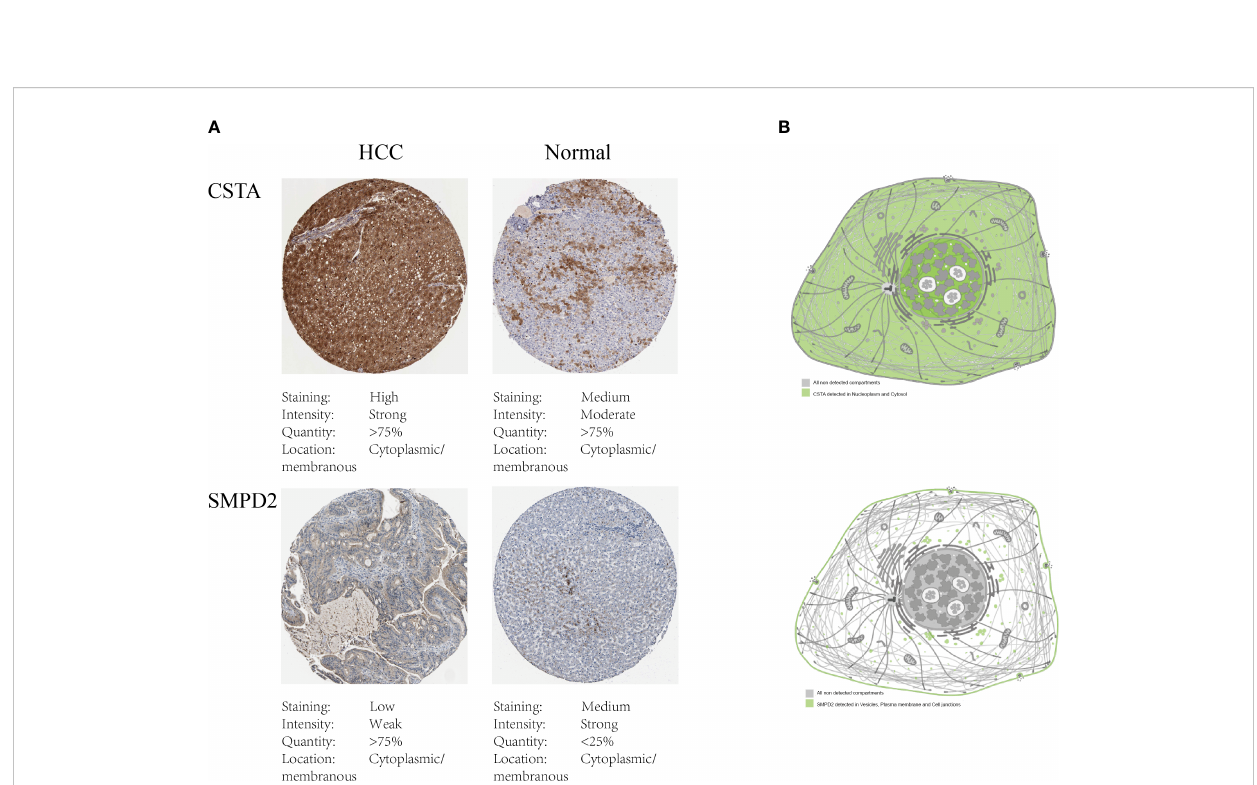
FIGURE 8 Protein expression of SPGs. (A) IHC results of CSTA and SMPD2. (B) The subcellular distribution of CSTA and SMPD2 proteins in human cell lines.